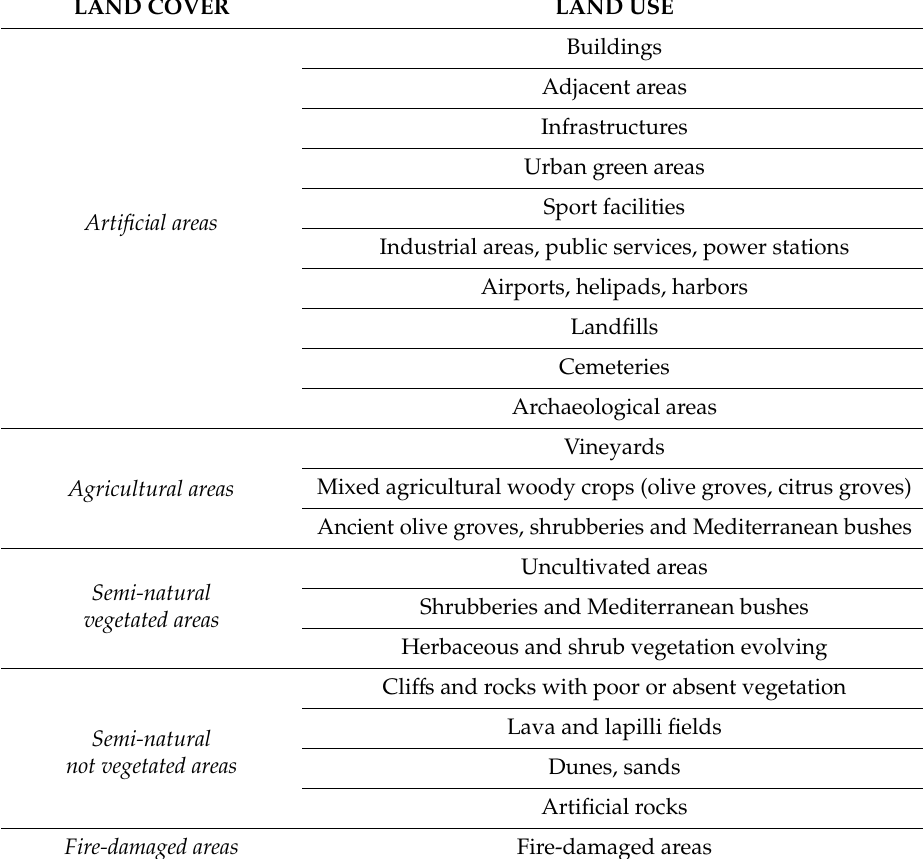
Table 3. Land cover (LC) and land use (LU)